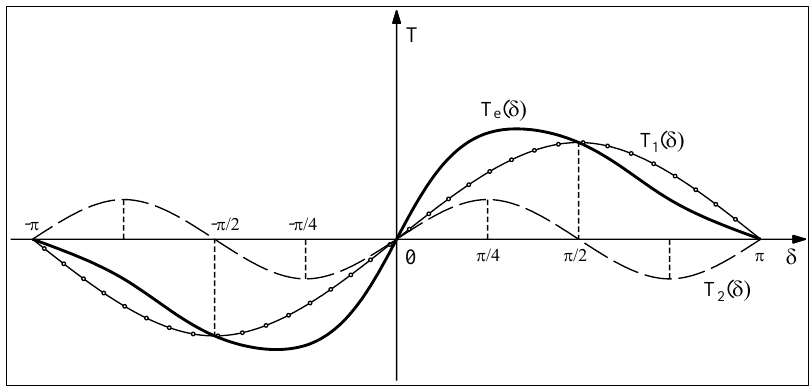
Figure 8. Torque–load angle characteristics of a salient pole synchronous motor